Question: Produce a descriptive caption suitable for publication.
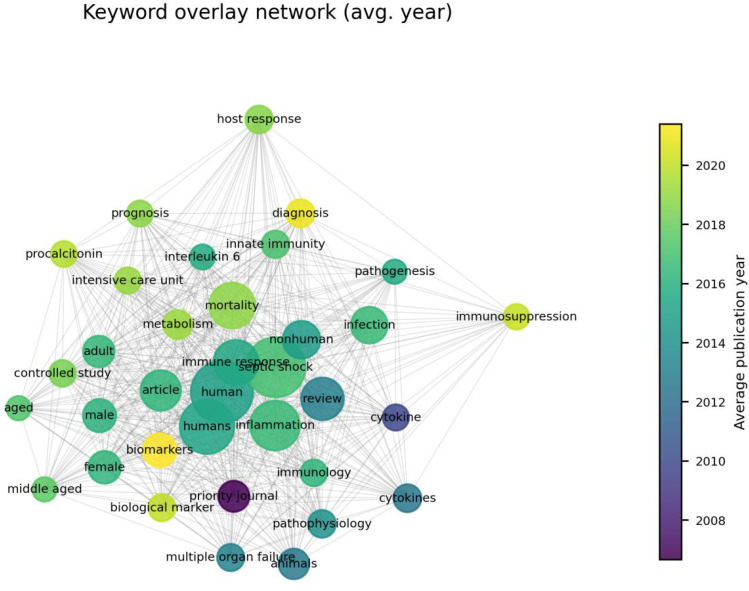
Answer: Keyword overlay network of host response-oriented sepsis research. The overlay network visualizes the temporal distribution of high-frequency keywords. Node size indicates keyword frequency, and node color represents the average publication year of documents containing each keyword. The image highlights the shift from classical inflammatory and immune activation themes toward biomarkers, molecular stratification, prognostic assessment, and precision-oriented research.